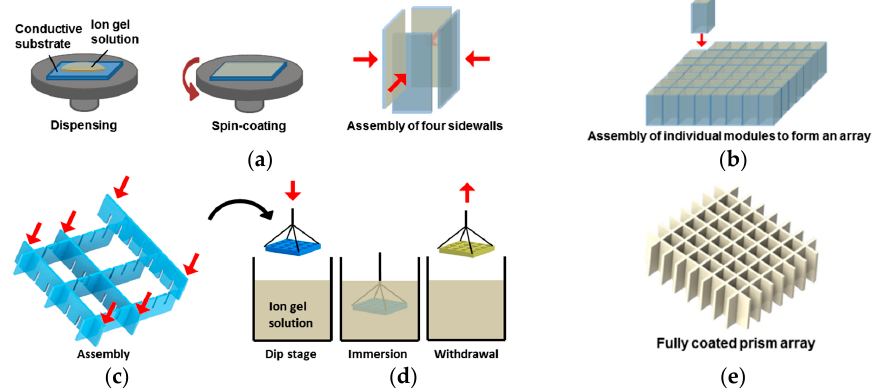
Figure 2. Schematics of typical spin- and dip-coating processes for fabricating arrayed liquid prisms as an example of 3D electrowetting-on-dielectric (EWOD) devices. ( a ) Four sidewall modules are separately spin-coated for gel layer deposition and then assembled to form a hollow 3D structure before being filled with two immiscible liquids; ( b ) For fabrication of n × n prism arrays, the spin-coating process needs to be repeated four times per module, i.e., 4 n 2 , with the gel layers more prone to damage during assembly; ( c ) A dip-coating process completes a single-step coating of the gel layer over the entire surfaces of the 3D assembled structures. For example, substrates with finger-like protrusions are first assembled to form the arrayed 3D structure; ( d ) The whole assembly is then dip-coated for the gel layer coating on the entire surface area; ( e ) A dip-coating approach offers a single-step solution with the benefits of simplicity, scalability, and high throughput for deposition of high-capacitance gel layers on 3D EWOD devices, while fully eliminating the risk of layer damage or contamination that may occur during the assembling